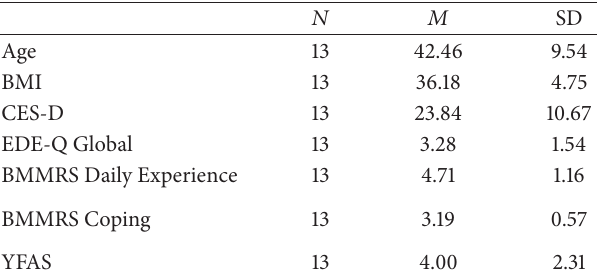
Table 2: Sample characteristics at